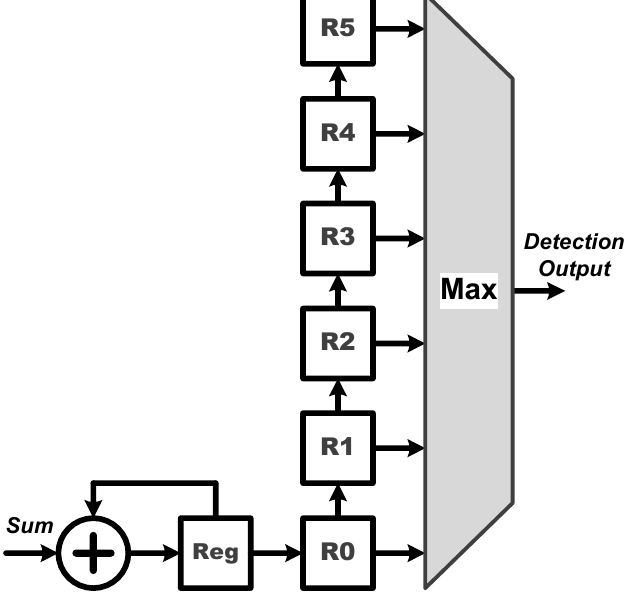
Figure 7. Architecture of the proposed Softmax module. Table 3. The designated values of the select input(s) of each multiplexer when operating at different layers Layer